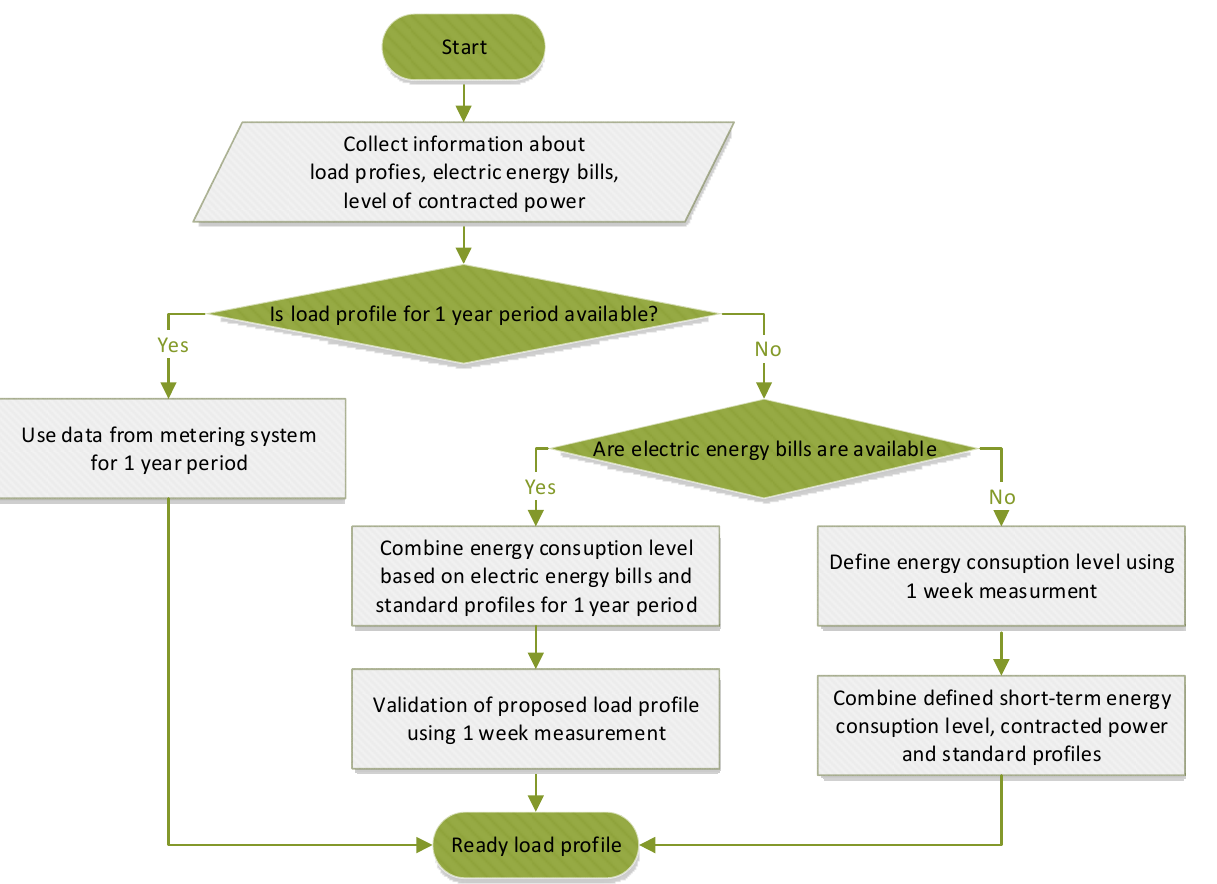
Figure 1. Proposed approach to obtain load